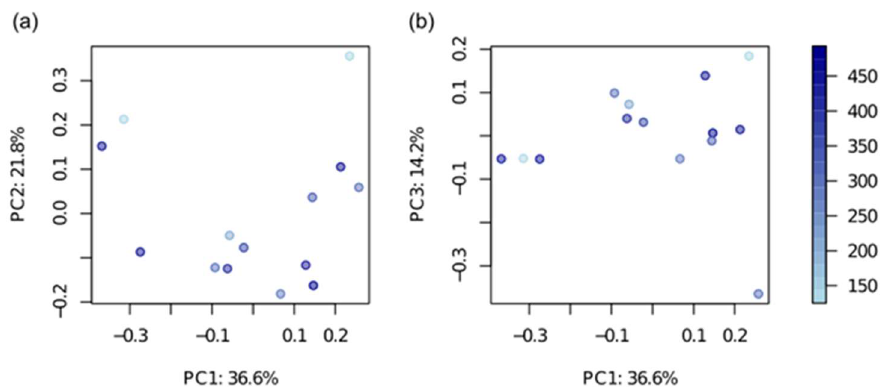
Figure 2. Principal coordinate analysis of bacterial composition on the level of genera. Bray-Curtis diversity metric was used for the distance matrix calculation. The circles are colored according to the creatinine value (from low—light blue, to high—violet). The axes notes include the percentage of total variance explained by the respective principal coordinate.